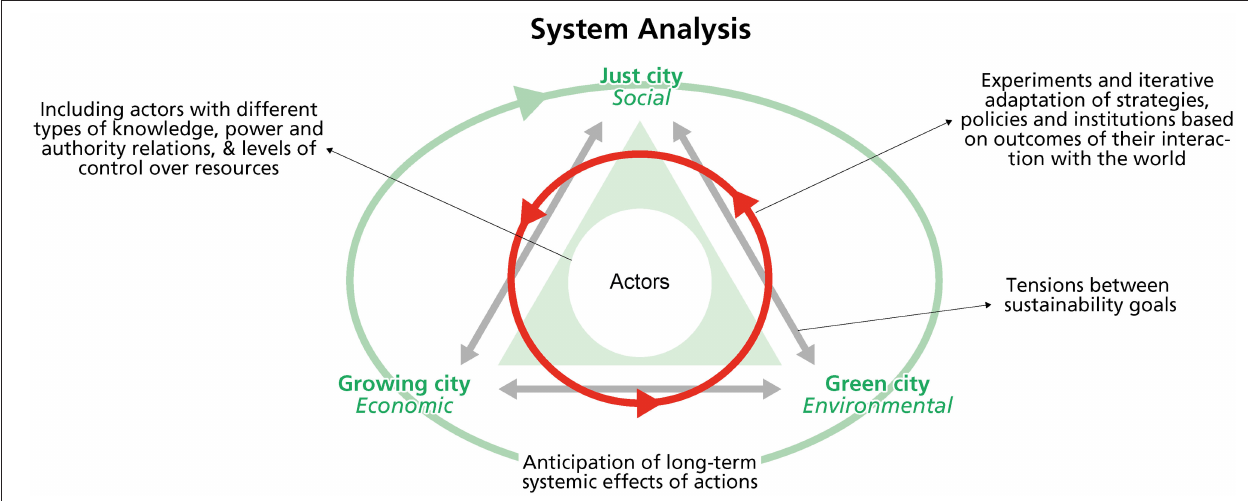
FIGURE 1 | System analysis in reflexive governance. The system analysis component of the analytical framework for reflexive governance broken down into its three subcomponents: (i) transdisciplinary knowledge development; (ii) experiments and adaptivity of strategies, and policies, and institutions; and (iii) anticipation of long-term systemic